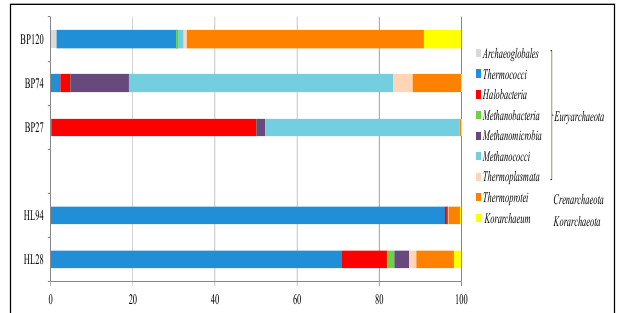
Figure 5. Relative abundances of the archaeal phyla and classes retrieved at di ff erent temperature conditions from sediment samples, at Black Point (BP120, BP74, and BP27) and Hot Lake (HL94 and HL28) sites.